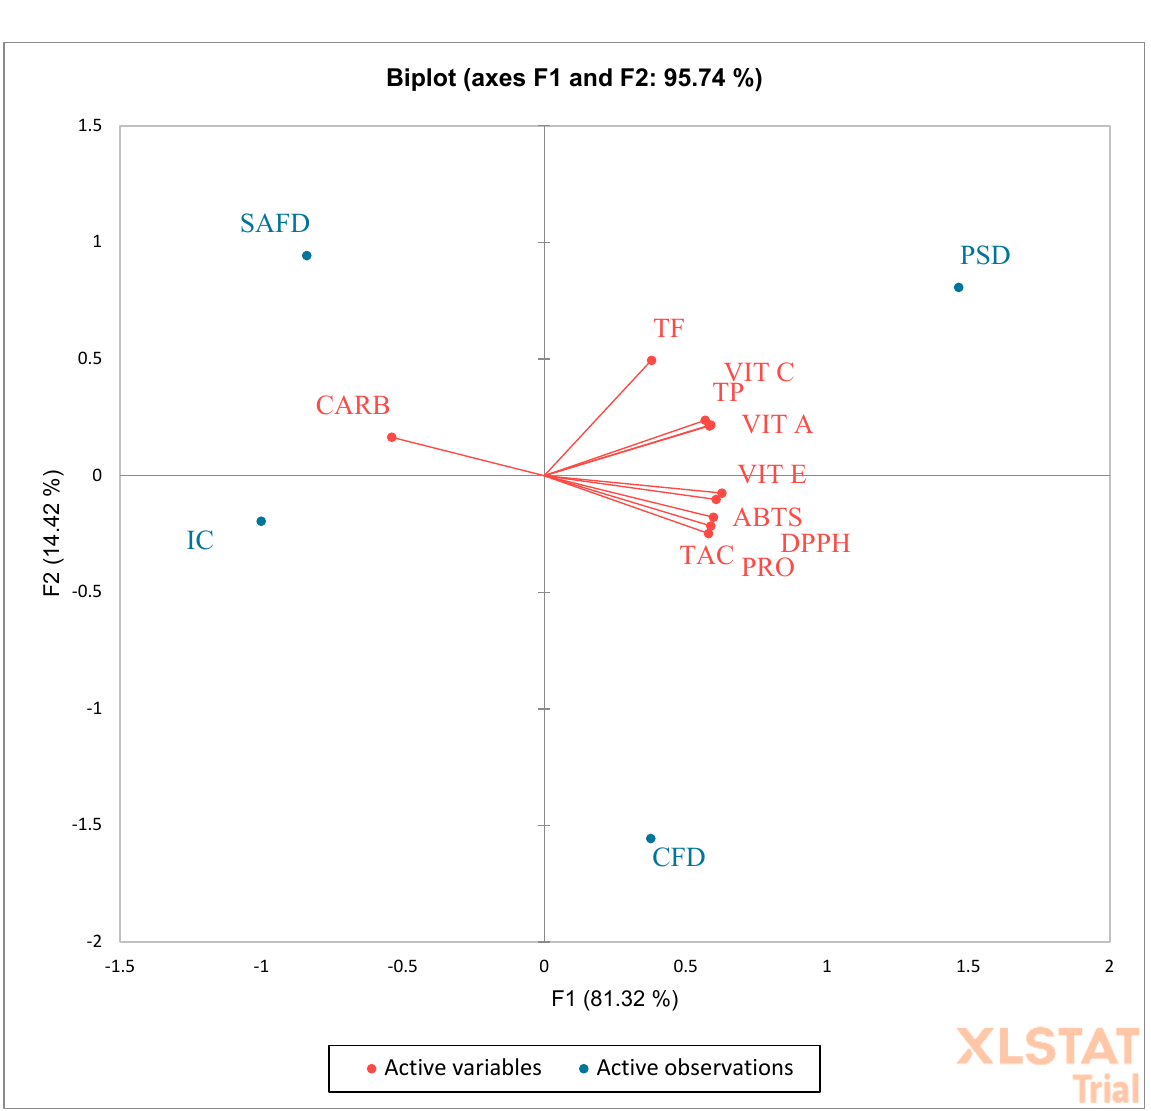
Figure 4. Total phenols (TP), total flavonoids (TF), proteins (PRO), vitamin C (VIT C), vitamin A (VIT A), vitamin E (VIT E), total carbohydrates (CARB), soluble proteins, 2,2-diphenyl-1-picryl-hydrazyl-hydrate (DPPH), total antioxidant capacity (TAC), and 2,2 ′ -azino-bis-3-ethylbenzothiazoline-6-sulfonic acid (ABTS) contained in peels of different pomegranate cultivars dried differently. PSD (spray-dried Wonderful peel, experimental data); CFD (Calabrian Wonderful peel freeze-dried, experimental data); SAFD (South African Wonderful peel freeze-dried, literature data); IC (Indian cultivar peel freeze-dried, literature data).